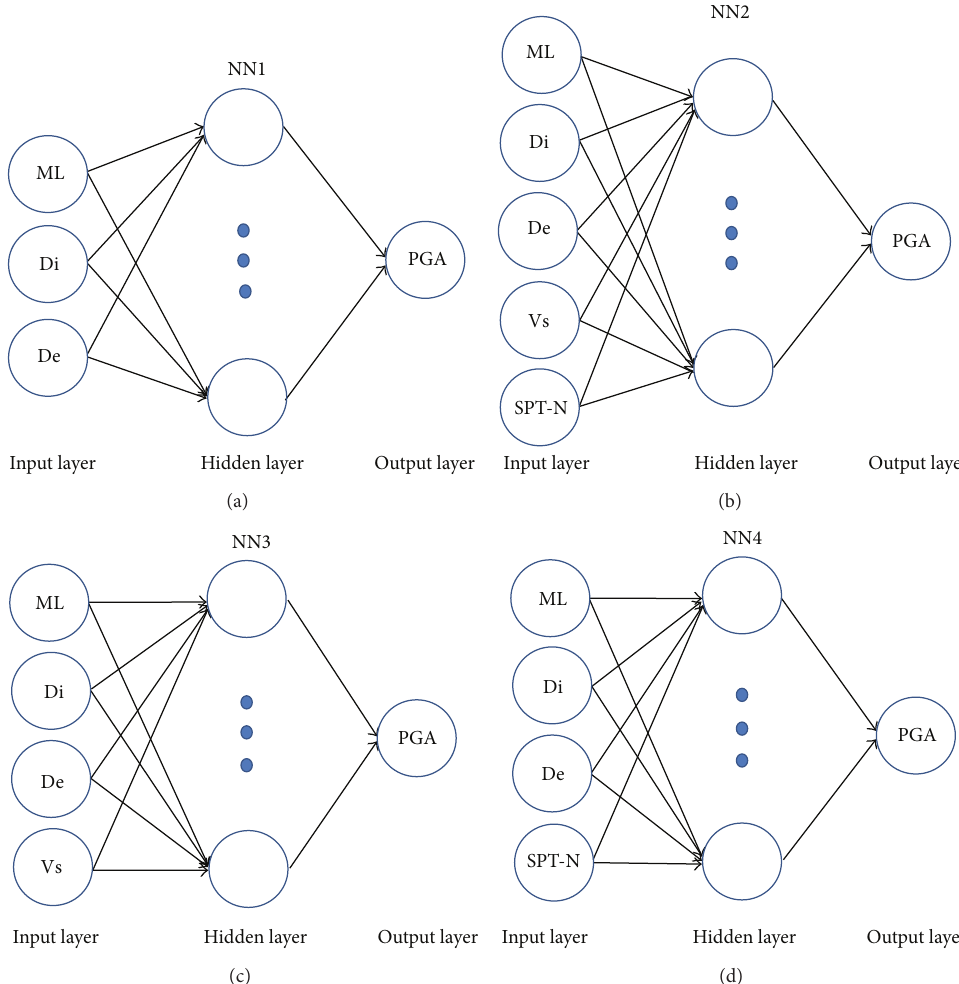
Figure 3: Four neural network models with various input parameters and neurons in the hidden